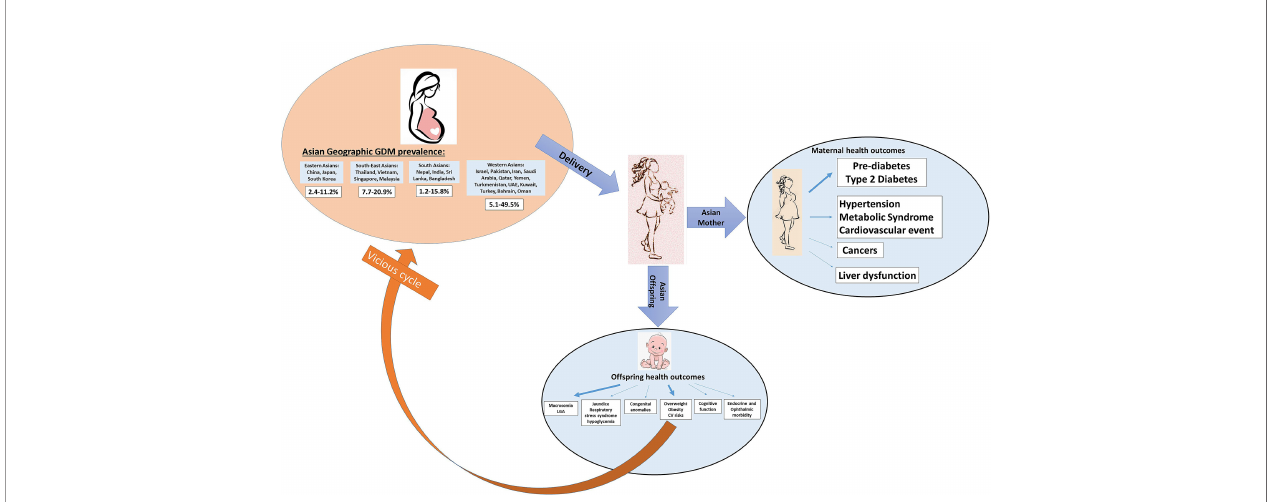
FIGURE 4 | Schematic graphs of GDM leading transgenerational health outcomes in Asian studies. The arrow represents the found associations between GDM and different transgenerational outcomes. A thicker arrow indicates a higher number of studies reported on this